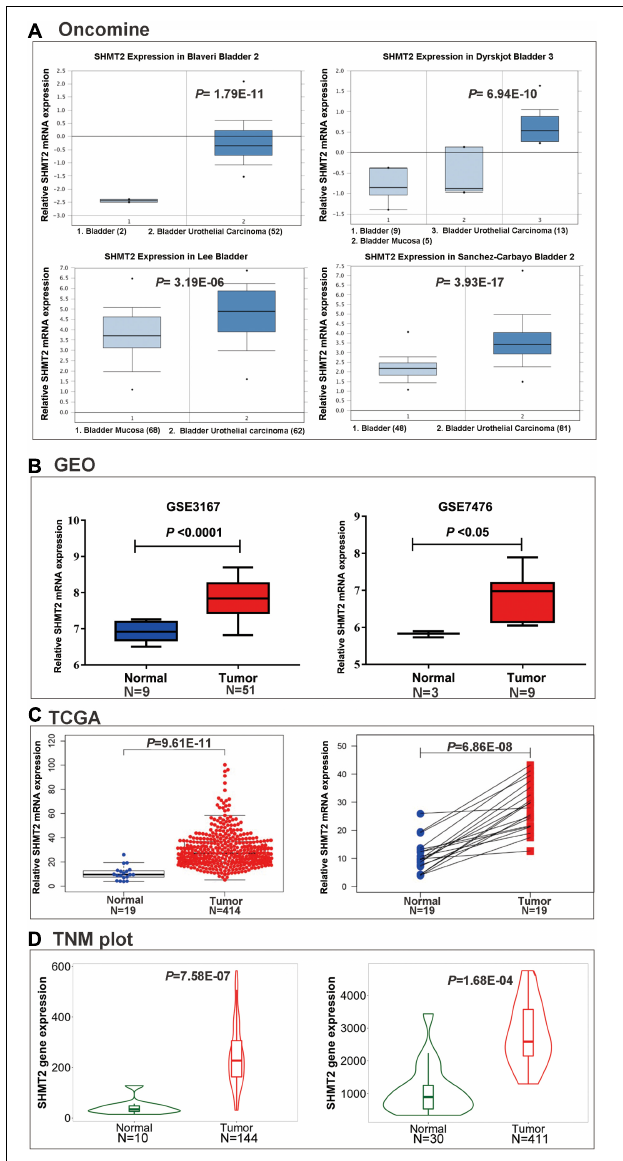
FIGURE 2 | SHMT2 expression in BLCA tissues. (A) SHMT2 was overexpressed in BLCA tissues than normal tissues in four oncomine data sets (Blaveri bladder, P = 1.79E-11; Dyrskjot bladder, P = 6.94E-10; Lee bladder, P = 3.19E-06; Sanchez-Carbayo bladder, P = 3.93E-17). (B) SHMT2 was upregulated in BLCA tissues in two GEO data sets (GSE3167, P < 0.0001; GSE7476, P < 0.05). (C) SHMT2 expression in TCGA-BLCA cases was significantly higher than that in normal bladder tissues ( P < 0.0001). (D) SHMT2 was overexpressed in BLCA tissues than normal tissues in TNMplot database (left-Genechip, P = 7.58E-07; right-RNA-seq, P = 1.68E-04). P < 0.05 was recognized as statistically significant.